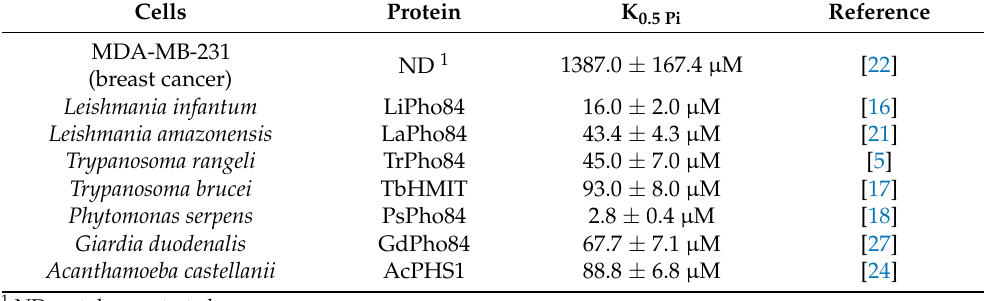
Table 2. Kinetic parameters of H + -dependent Pi transporters in cancer and protozoan cells. Cells